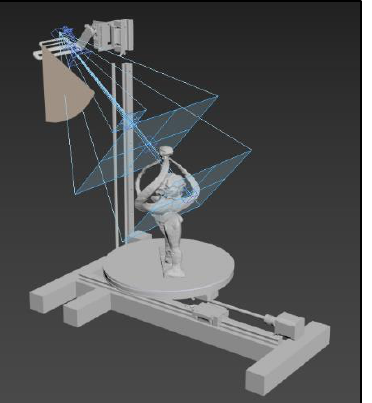
Figure 3. Virtual prototyping for lens depth of field simulation To appropriately angle the camera, a 20kg gear servo was used, with a servo driver to power the servo at a different voltage to the stepper motors. This also has an additional benefit of cleaning signal noise from the system therefore reducing the likelihood of juddering to ensure a smooth motion during data capture activities.